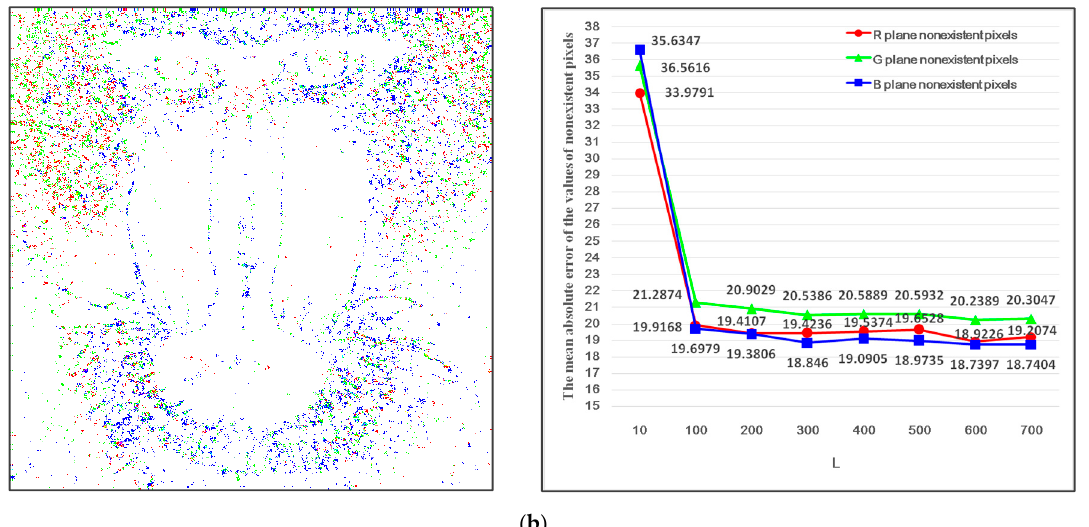
Figure 3. The influence of neuron number in ELM algorithm on null-value approximation. ( a ) Lena image depicted with null-value pixels (left) and the variety of MAD with L (right); ( b ) Baboon image depicted with null-value pixels (left) and the variety of MAD with L (right).